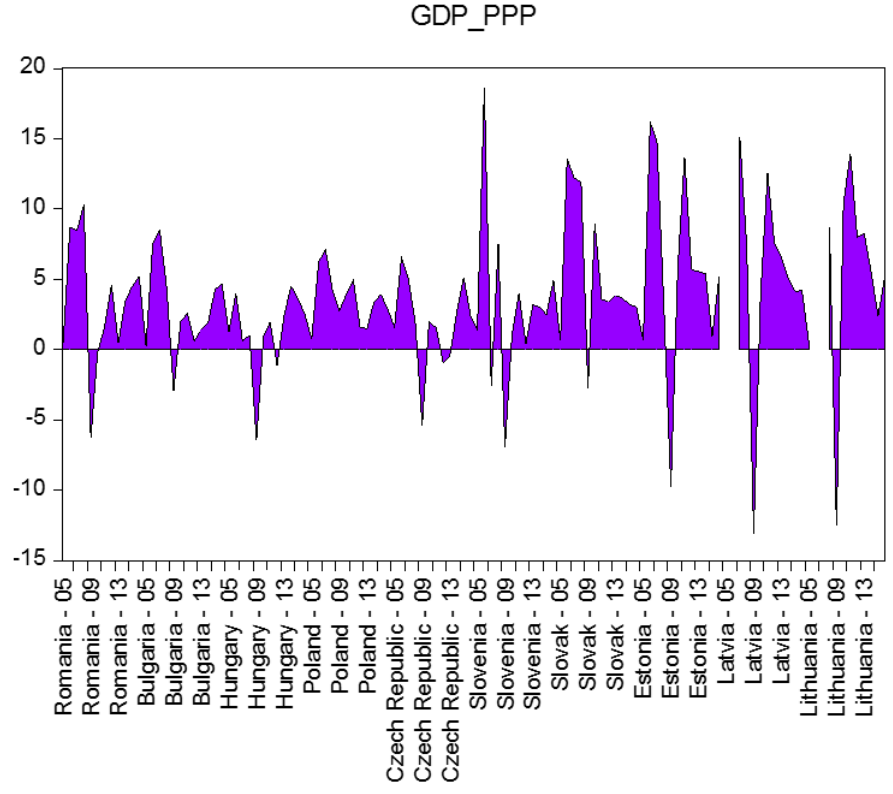
Figure 3. Gross domestic product purchasing power parity (GDP_PPP) annual percentage change in CEE countries.